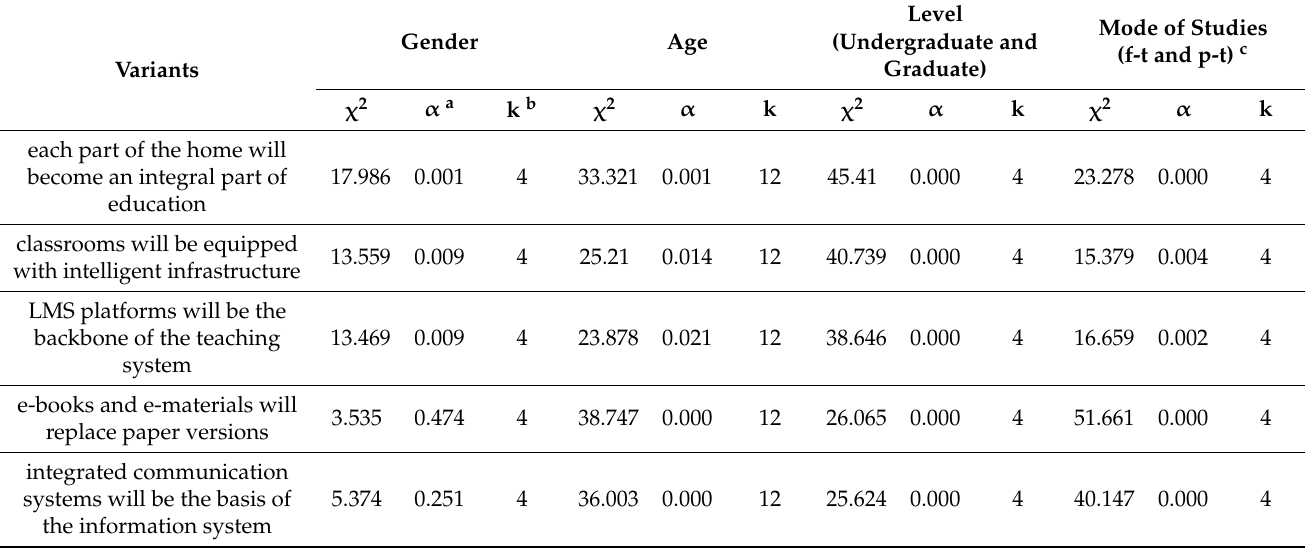
Table 3. Instrumental support for Smart learning in terms of gender, age, level, and mode of study–test of independence χ 2 .